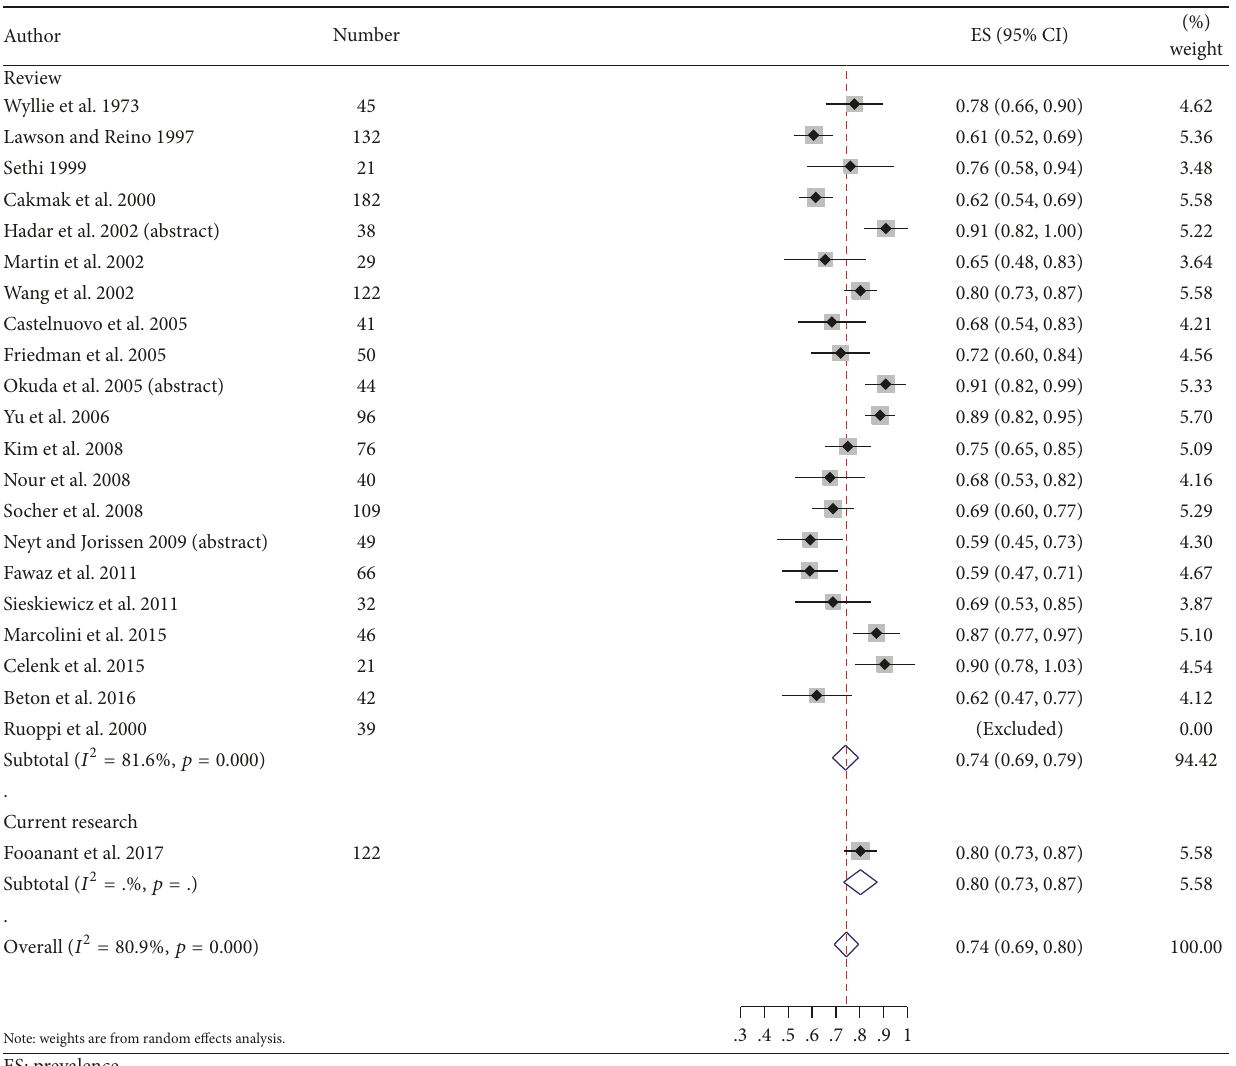
Figure 3: A forest plot shows the prevalence of infection/inflammation among the sphenoid sinus lesions.